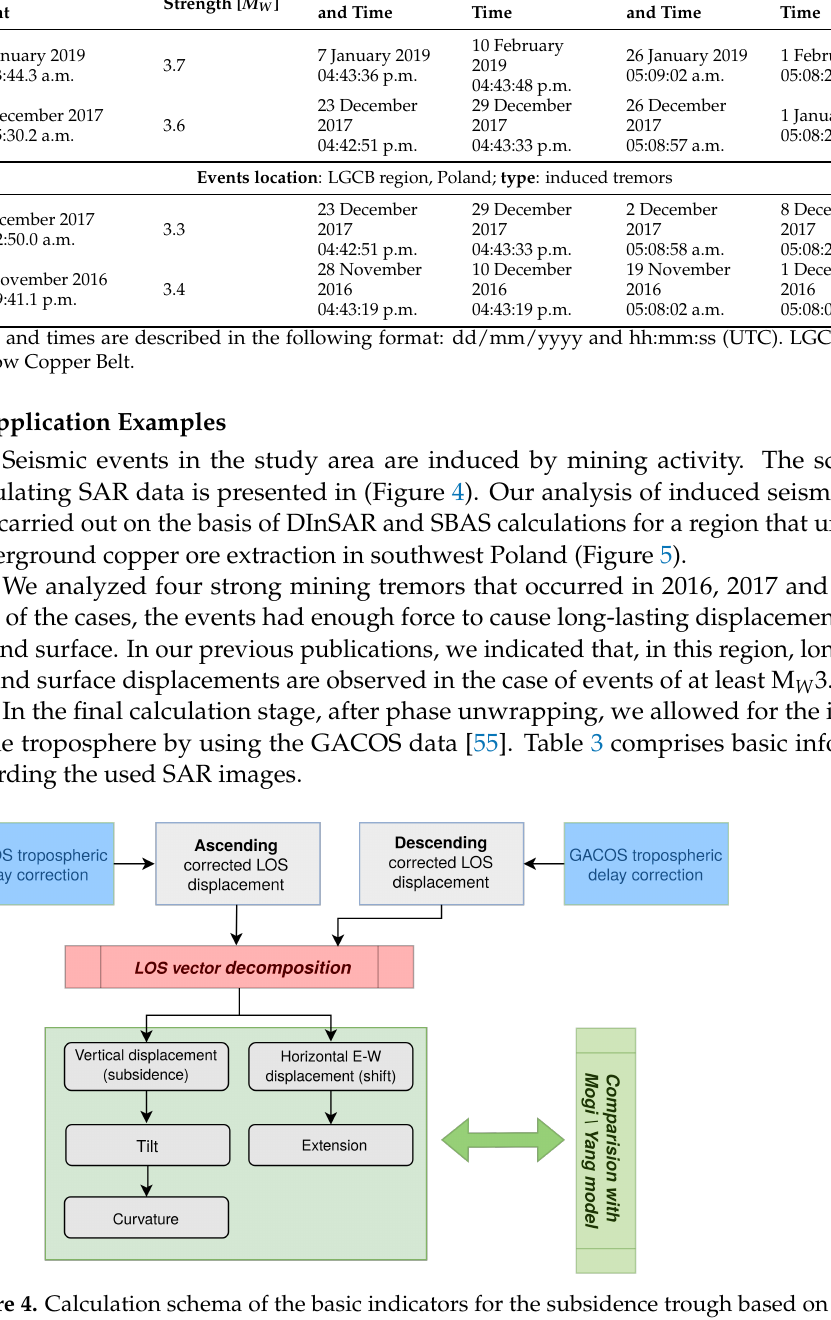
Figure 4. Calculation schema of the basic indicators for the subsidence trough based on SAR data with tropospheric correction (Generic Atmospheric Correction Model (GACOS)) and theoretical Mogi and Yang